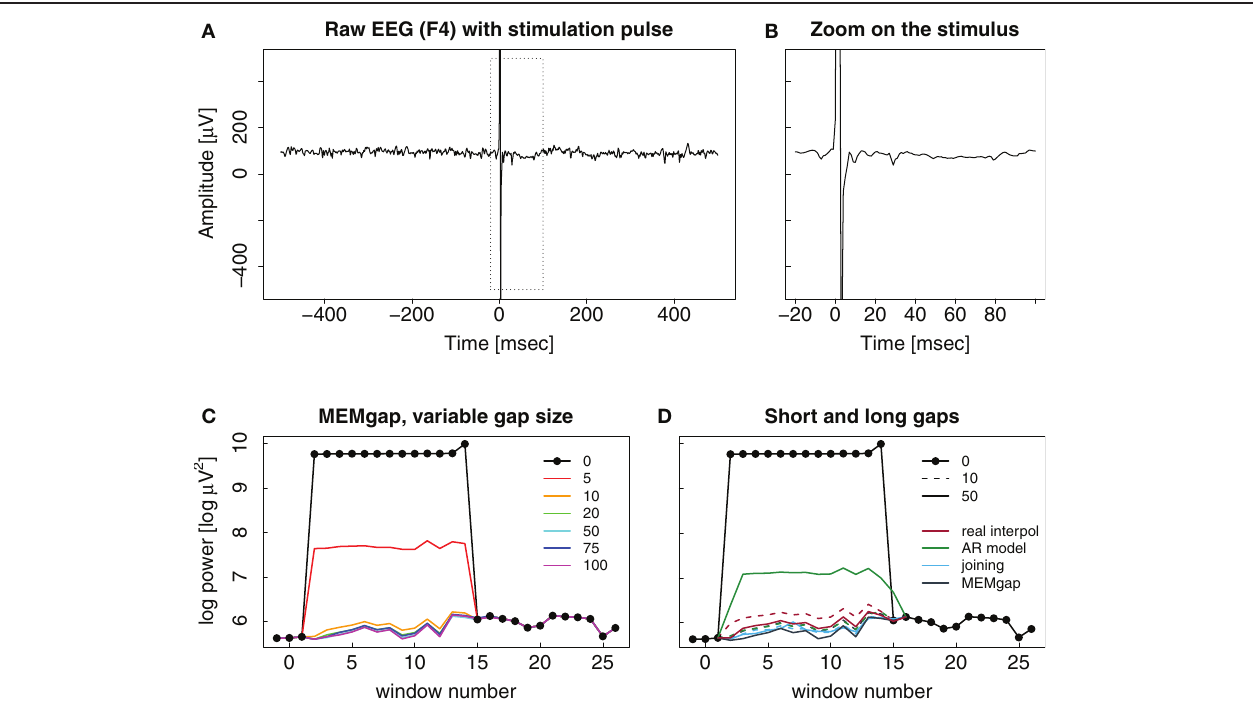
FIGURE 7 | Example trace of a TMS pulse applied over EEG channel (C4) but recorded on a distant channel (F4). (A–D) Same as in Figure 6 . Note the missing evoked activity in (A) and (B) after the pulse.